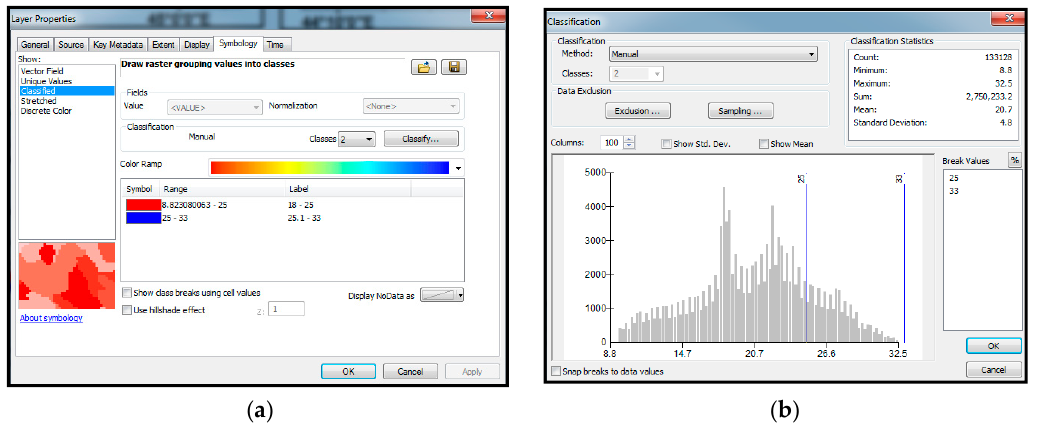
Figure 9. Classify command within ArcMap / GIS software: ( a ) Layer properties windows; ( b ) classification window.